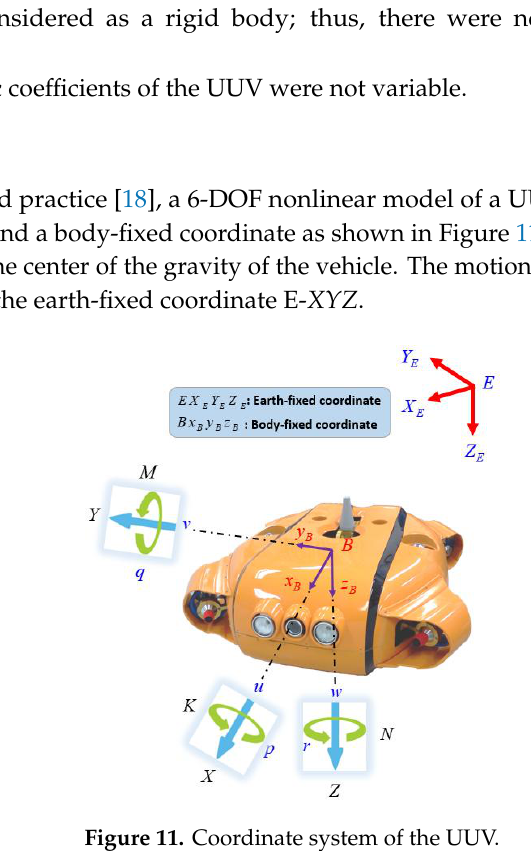
Figure 11. Coordinate system of the UUV.